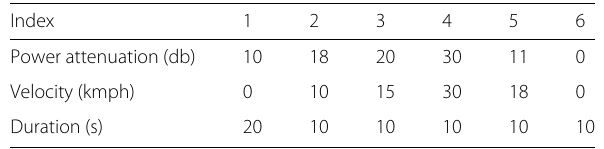
Table 4 Transition of attributes in the emulated